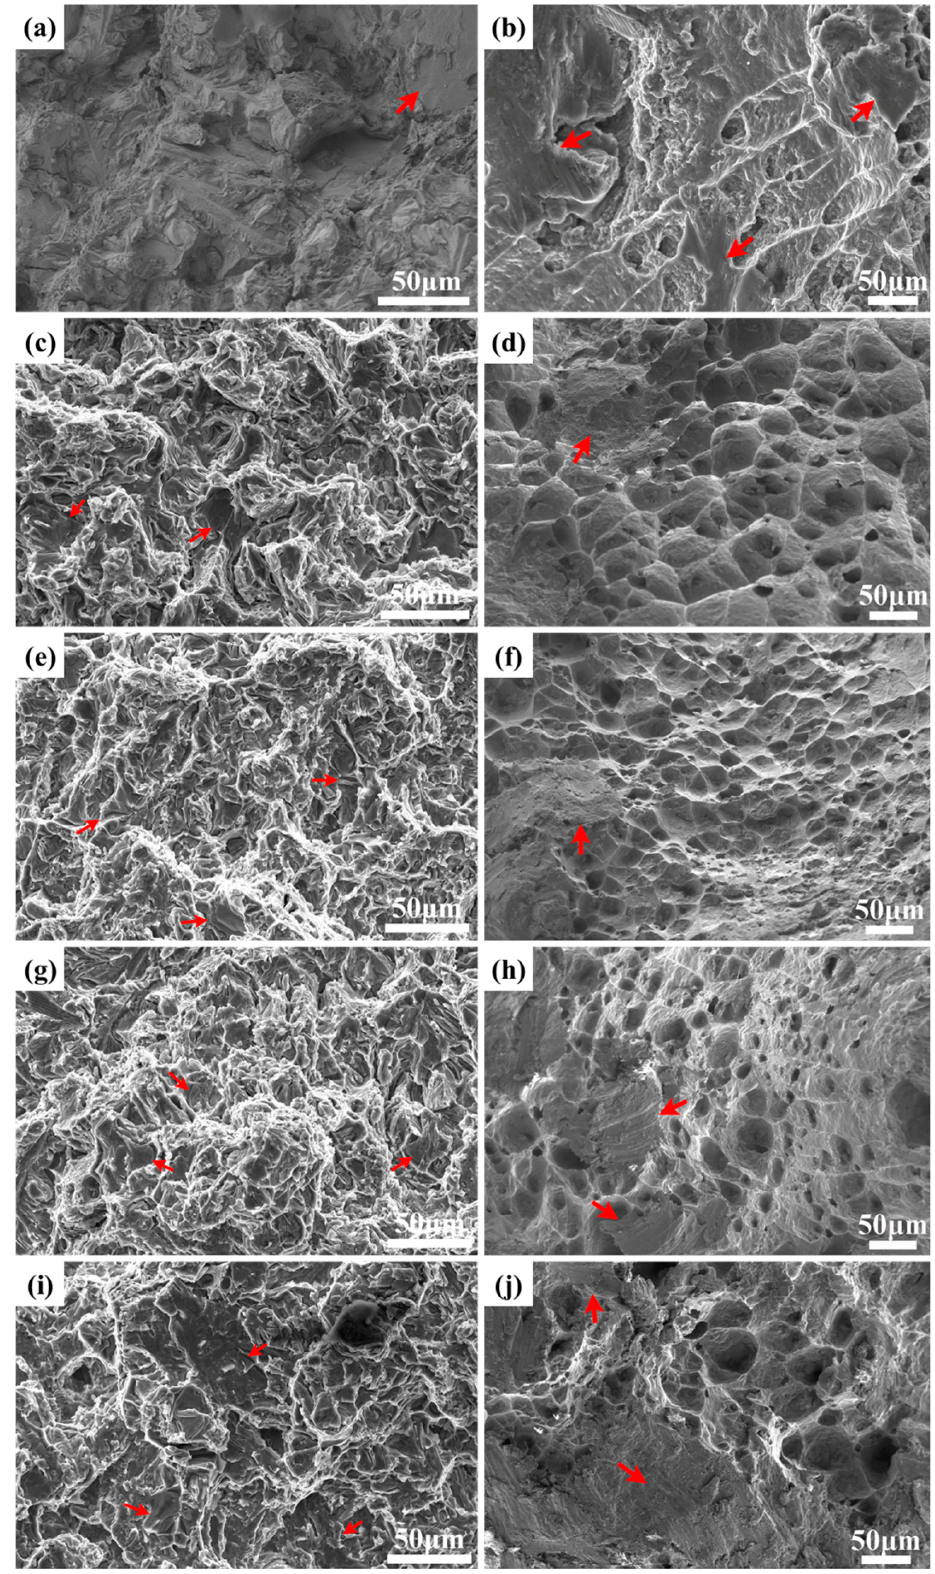
Figure 7. SEM images of fractured surfaces on the tensile specimens of heat-treated alloys at 25 °C and 400 °C: ( a , b ) 0 Ni alloy, ( c , d ) 0.5 Ni alloy, ( e , f ) 1.0 Ni alloy, ( g , h ) 2.0 Ni alloy, ( i , j ) 4.0 Ni alloy, ( a , c , e , g , i ) fractographs at 25 °C, ( b , d , f , h , j ) fractographs at 400 °C. The red arrows indicate the cleavage planes.